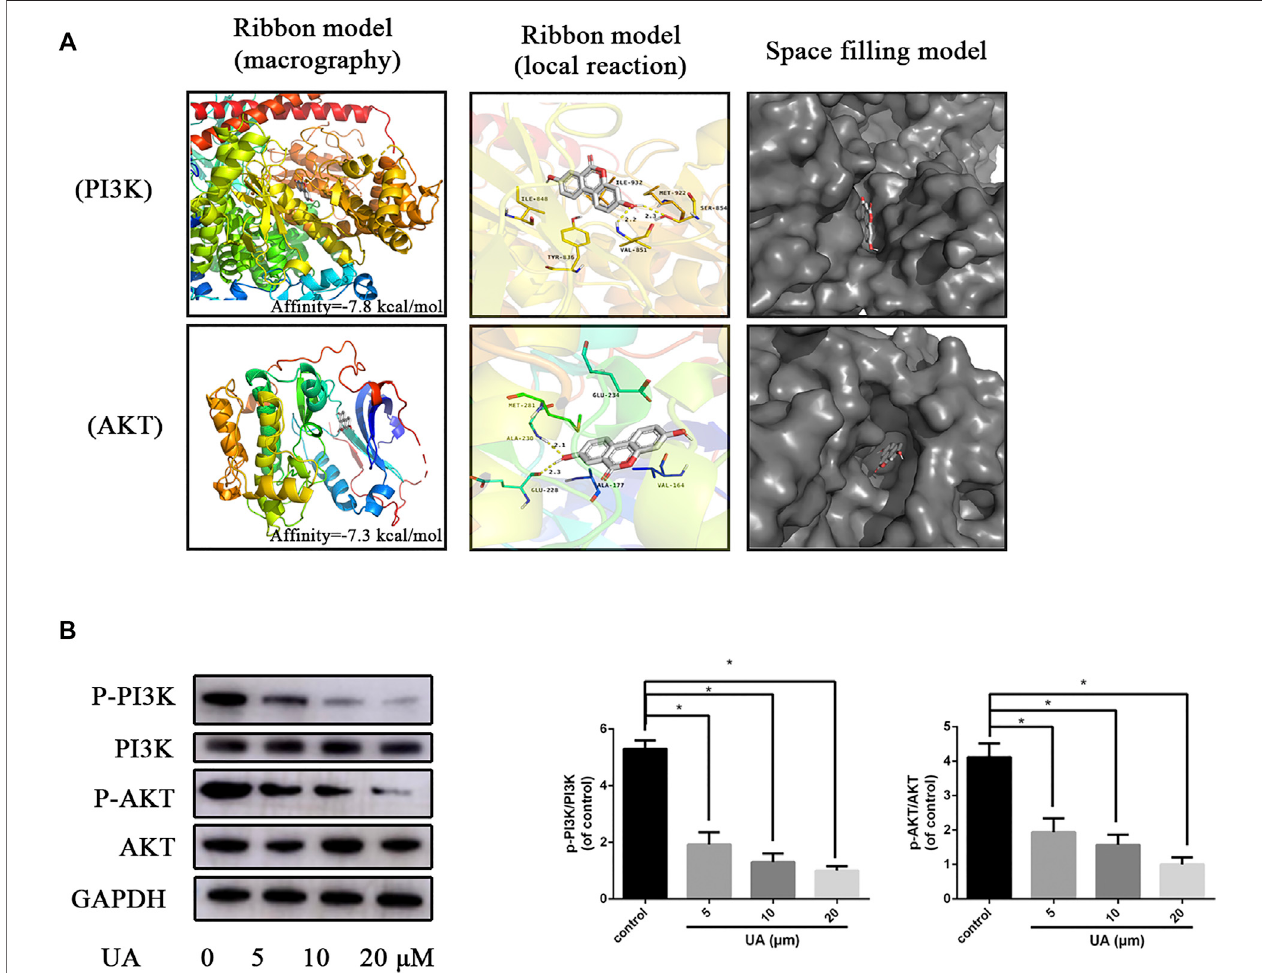
FIGURE3| UAsuppressesthePI3K/AKTpathway. (A) Theproteinresiduesareshownintheribbonmodelandspace- fi llingmodel.ThelocalreactionofUAshows VAL-851 and SER-853 interactions with the PI3K structure. UA shows ALA-230 and GLU-228 interaction with the AKT structure. The space- fi lling model shows the binding of UA in the inhibitory binding pocket. (B) WB was used to detect the expression of PI3K and AKT proteins in HUVECs 48 h after UA treatment. Statistics of the WB experiment. The data represent mean ± SD ( n = 3) (* p < 0.05).